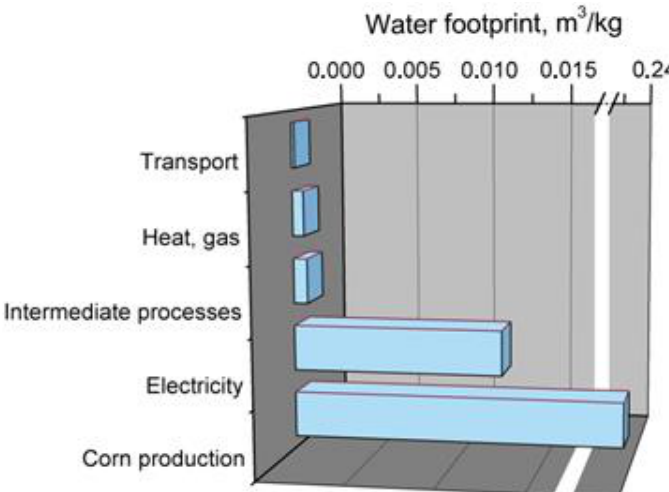
Figure 7. Main components of production system generating water footprint of poly(lactic acid).